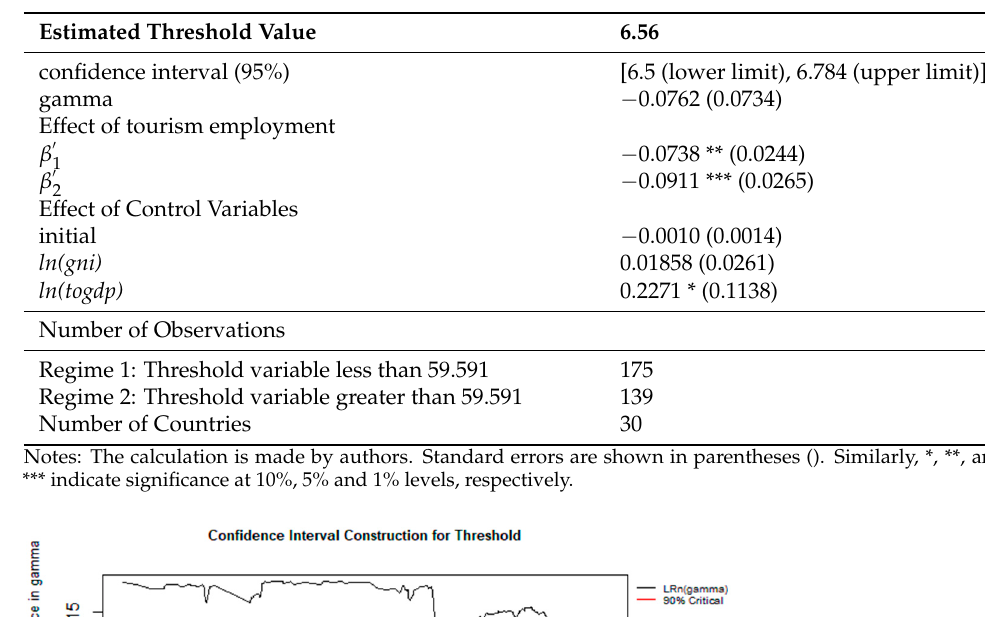
Table 4. Dynamic panel threshold estimates for Model 2.